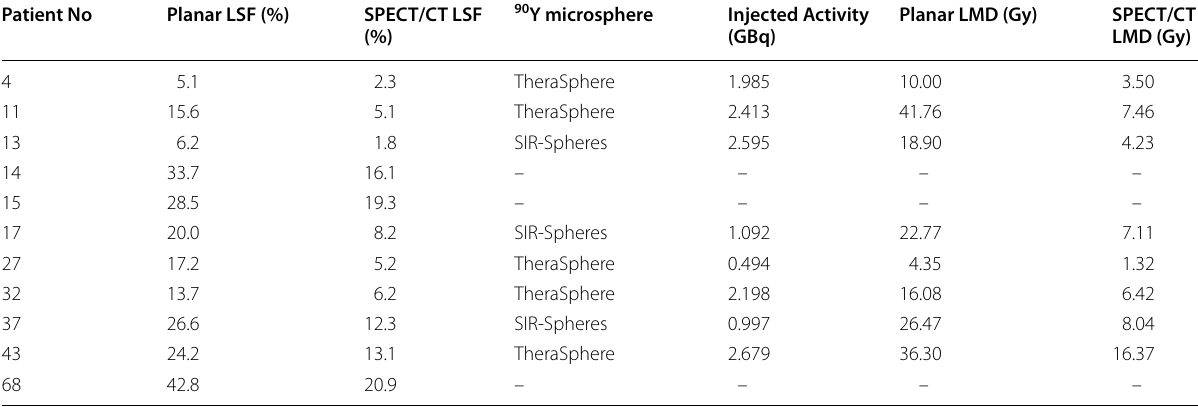
Table 3 Treatment planning and differences in lung dose estimates as determined from planar imaging vs. SPECT/CT (LDM) 99m Tc- MAA imaging in selected patient